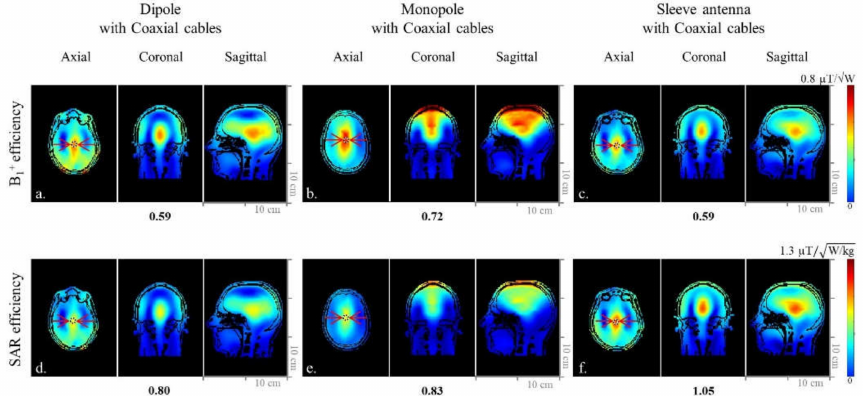
Figure 5. Simulated B 1+ efficiency ( a – c ) and SAR efficiency ( d – f ) maps of the 8-channel dipole, monopole, and sleeve antenna arrays with coaxial cables in the axial, coronal, and sagittal planes. The sleeve antenna array showed relatively small coverage in the phantom (Figure